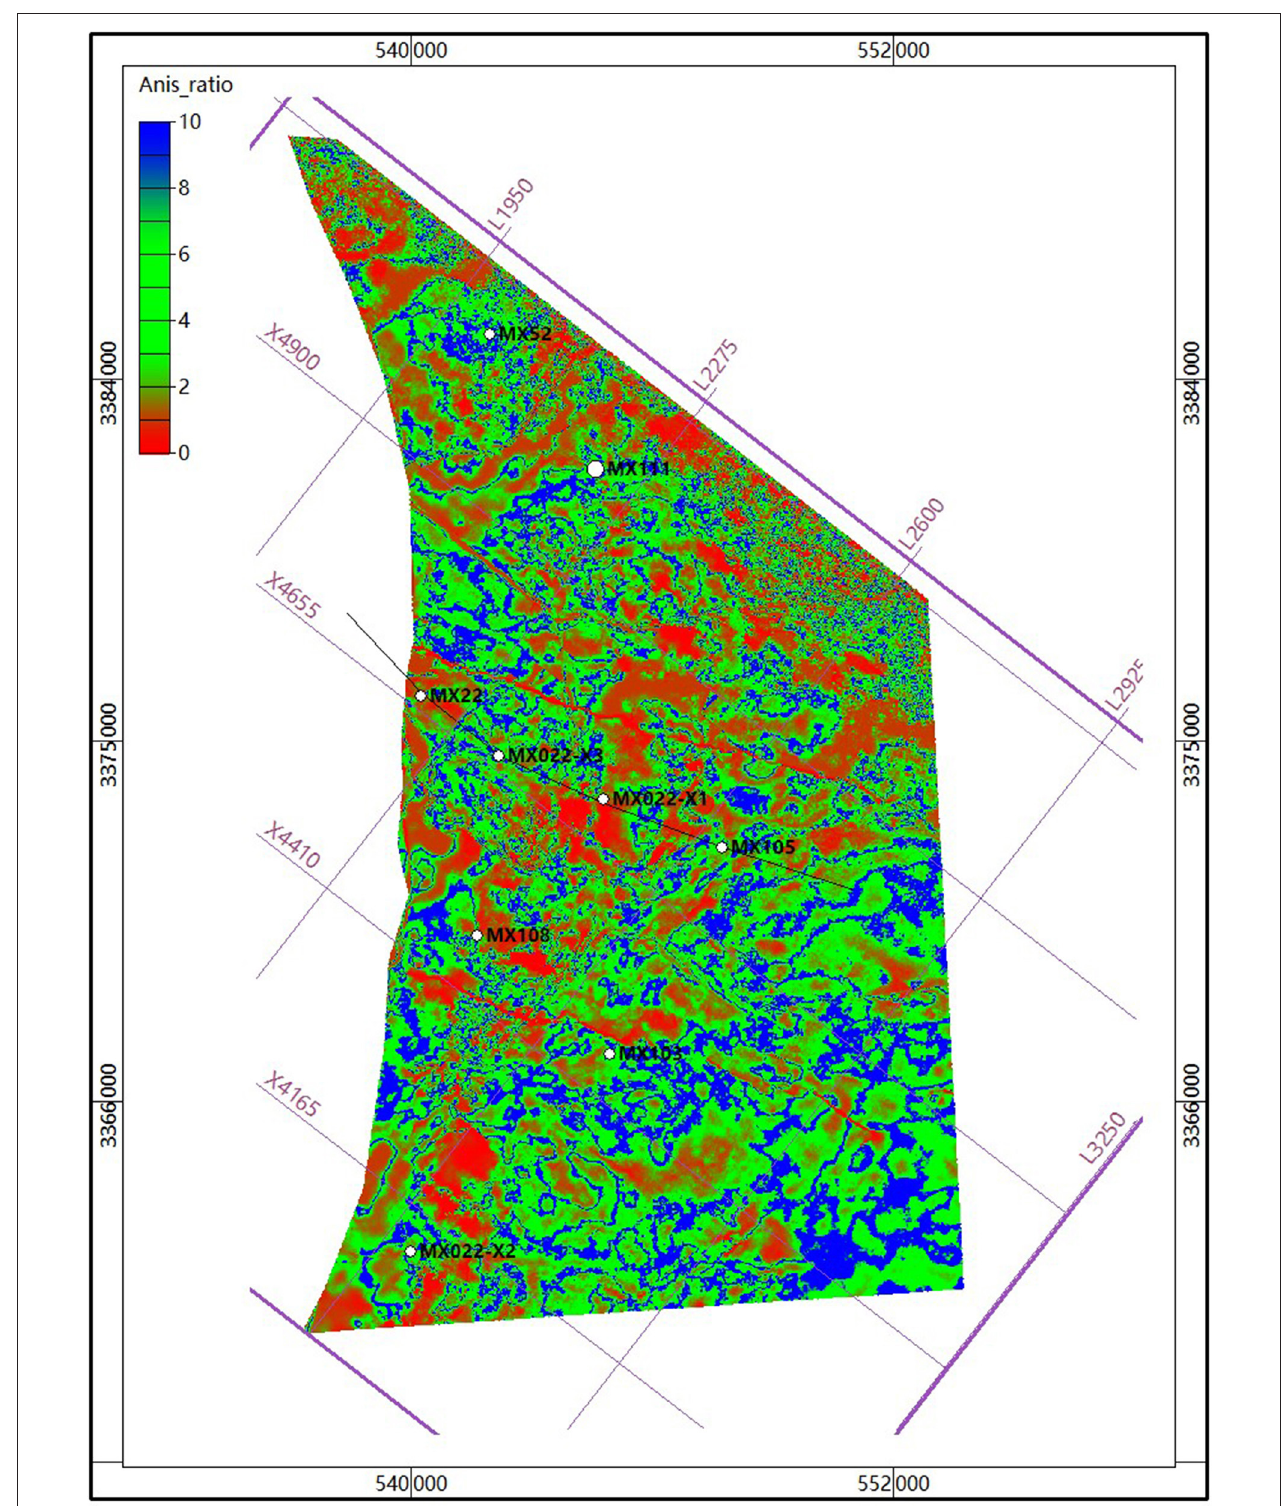
FIGURE 10 | New seismic attribute extracted in the study area.